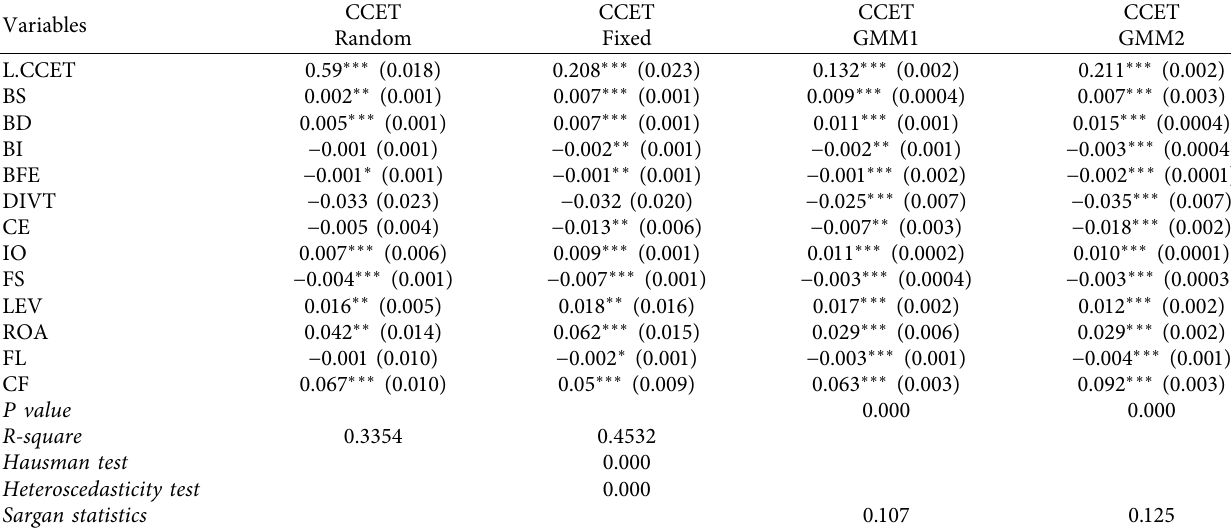
Table 4: Board financial expertise impact on cash holding of family